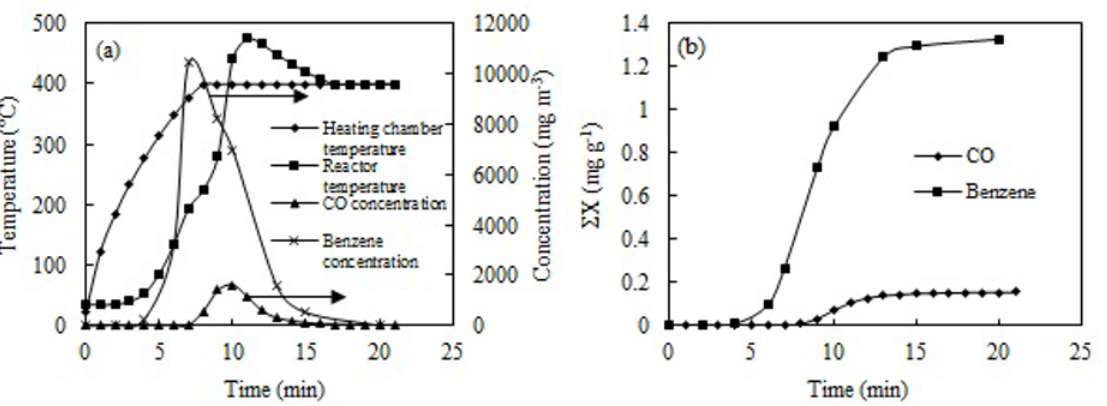
Table 3. Total oxidation of BTX at different operating conditions. VOC Inlet concentration,